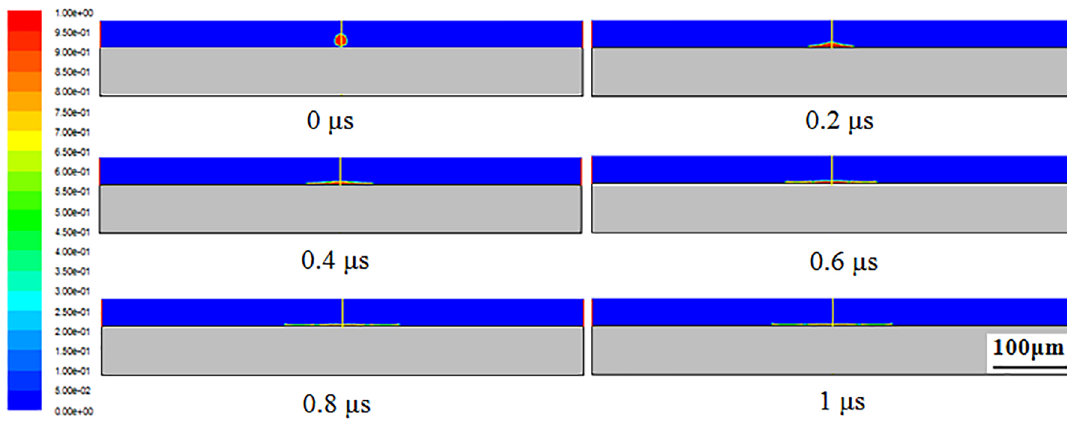
Figure 2. Deformation and solidification process of TWAS droplet (ø25 μm, 100 m/s).